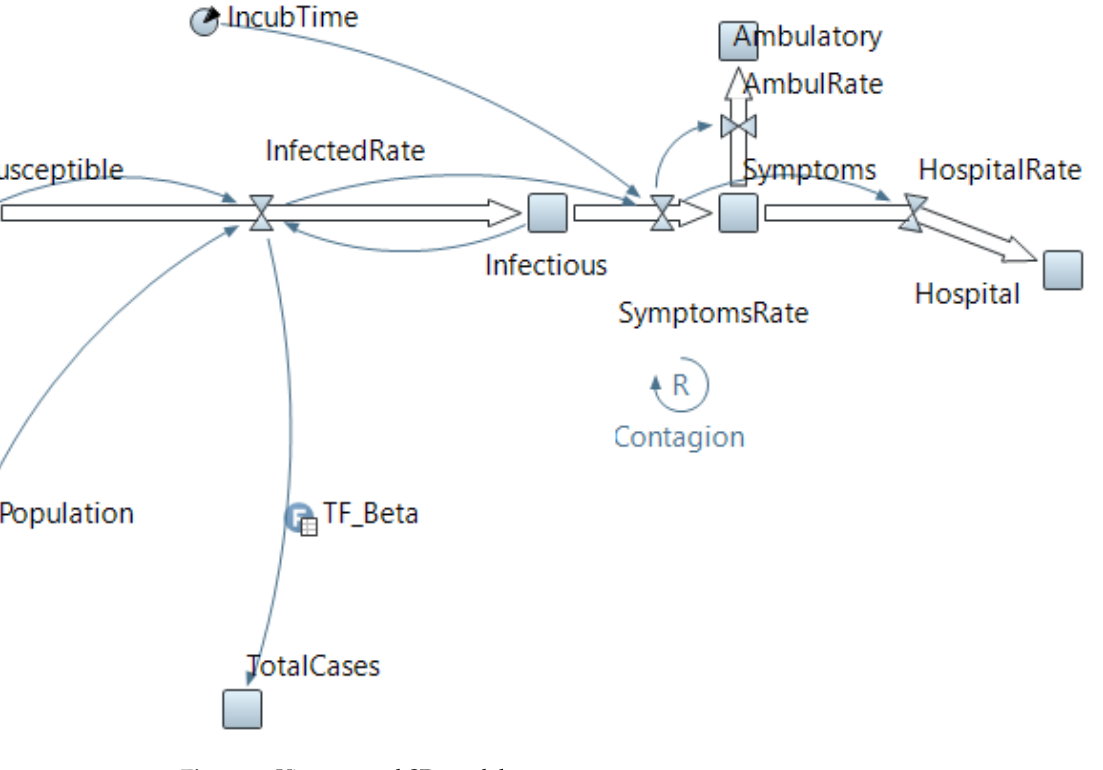
Figure 1. Virus spread SD model.